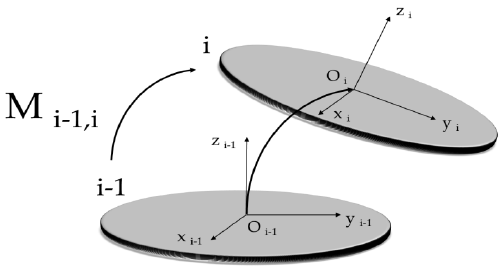
Figure 2. Description of general limited degree of freedom (DOF) parallel manipulator system.